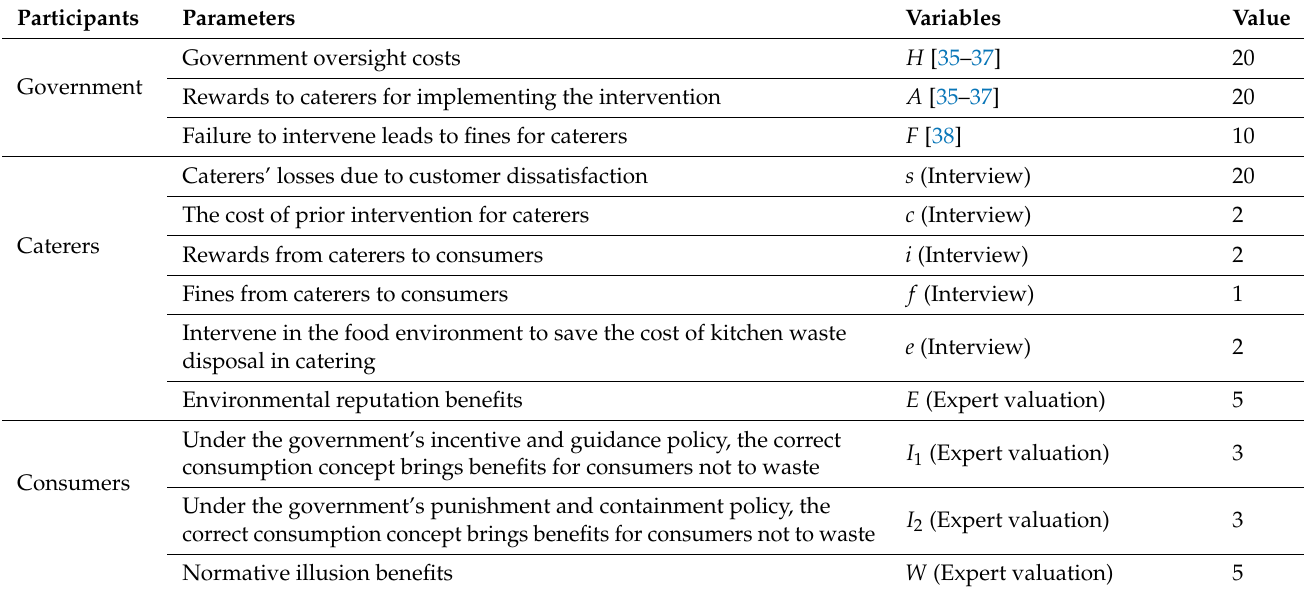
Table 3. The initial values of all variables (unit: CNY 10 2